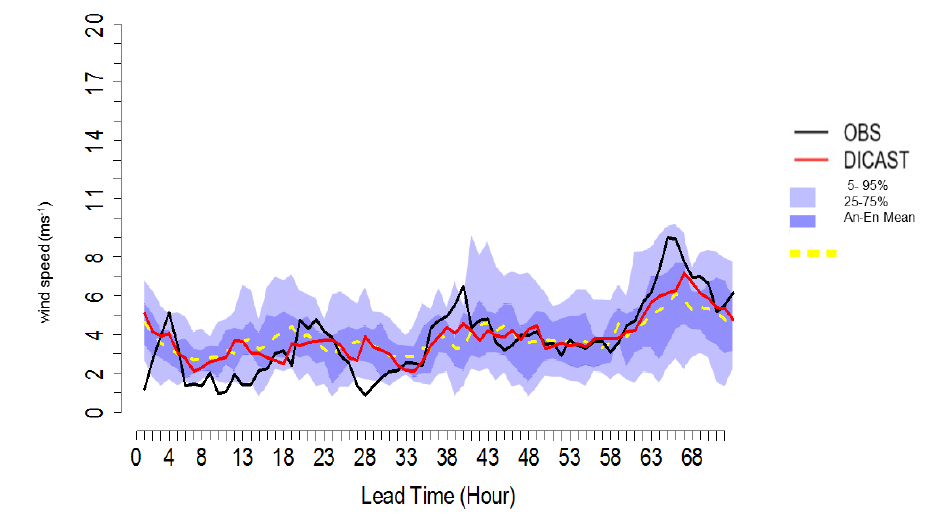
Figure 5. Example of an analog ensemble forecast probability density function (PDF) over one station of the dataset. The blue shadings correspond to the 25–75 ( darker ) and 5–95 ( lighter ) quantiles. The black and yellow dashed lines represent the wind speed observations and AnEn ensemble mean, respectively. The red line is the DICast wind speed forecast. AnEn: analog ensemble.